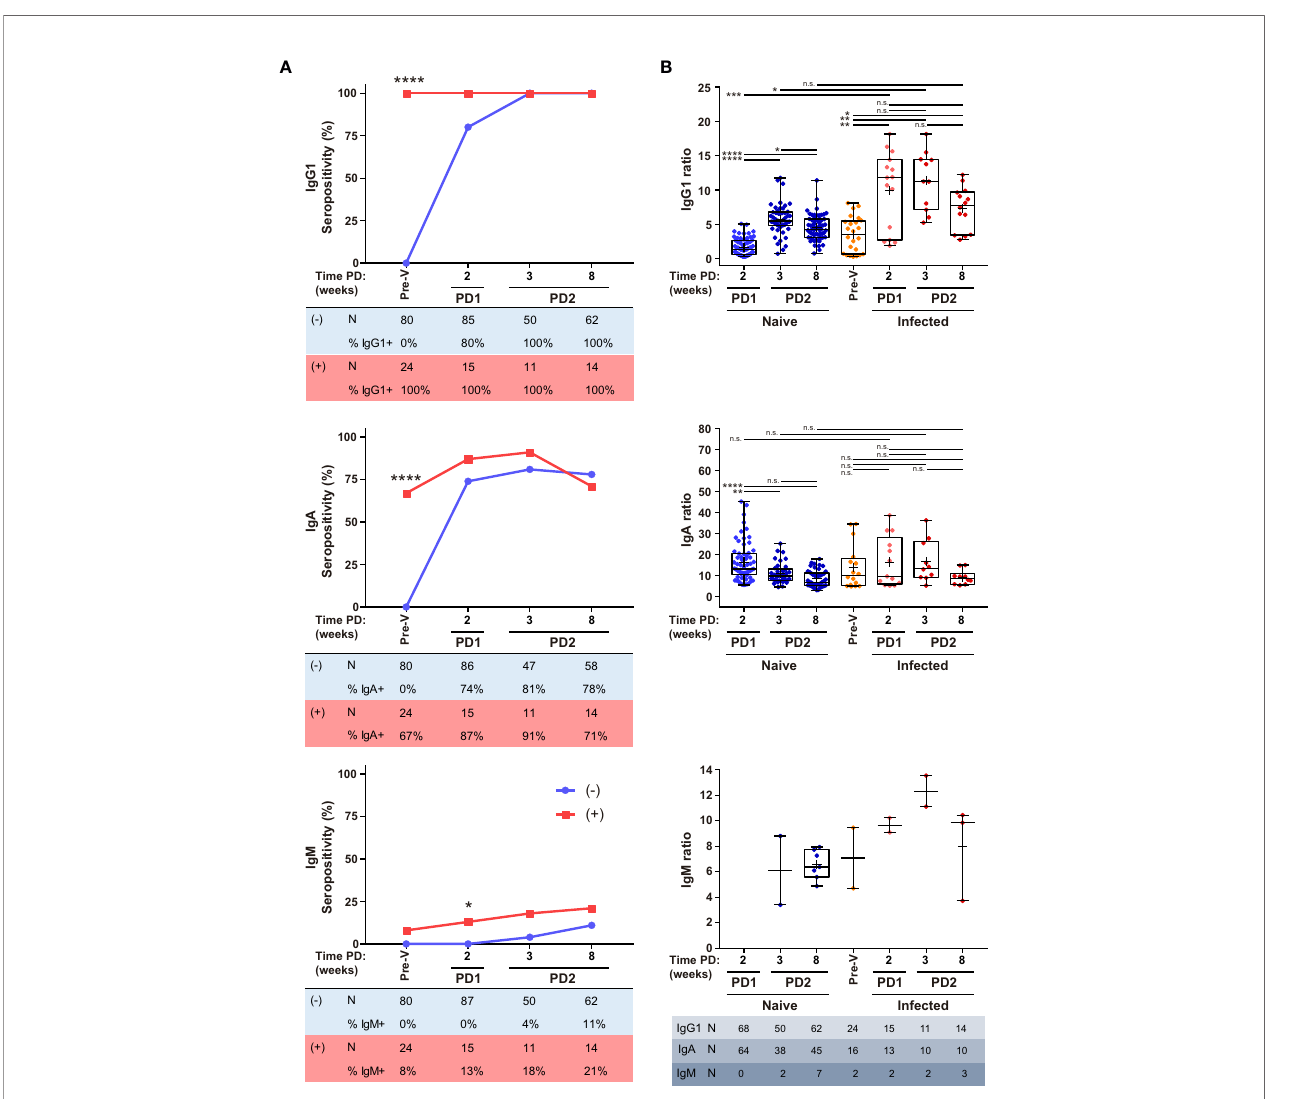
FIGURE 5 | Humoral response in previously infected donors. IgG1, IgA and IgM seropositivity (A) and titers (B) of naïve (-) and previously infected and IgG1 seropositive (+) donors vaccinated with BNT. Total number and percentage of positive samples are shown in tables below seropositivity graphs. Sample collection time as described in Figure 2 . Median, line inside boxes; mean, +; bars, min and max values. P values were determined using two-tailed Fisher ’ s exact test (A) and Brown-Forsythe ANOVA with Games-Howell ’ s correction (B) . n.s., no signi fi cance; *p < 0.05; **p ≤ 0.01; ***p ≤ 0.001; ****p <